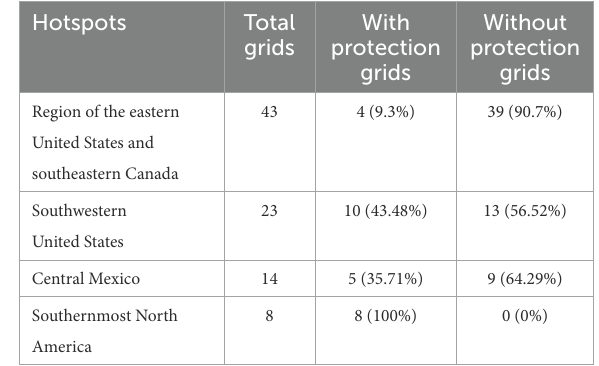
TABLE 2 Number of total grids with and without